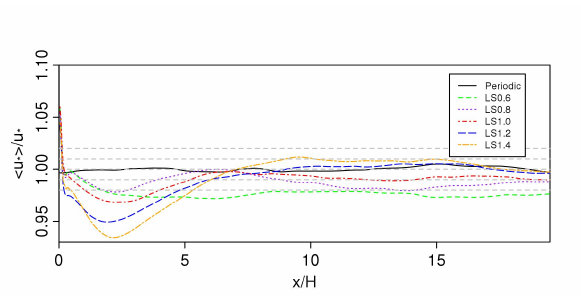
Figure 7. Development of local friction velocity (averaged over spanwise direction and time) with various integral length scales. (cid:104) u ∗ (cid:105) is the local friction velocity along the streamwise direction, and u ∗ is the x − y − t -averaged friction velocity for the periodic